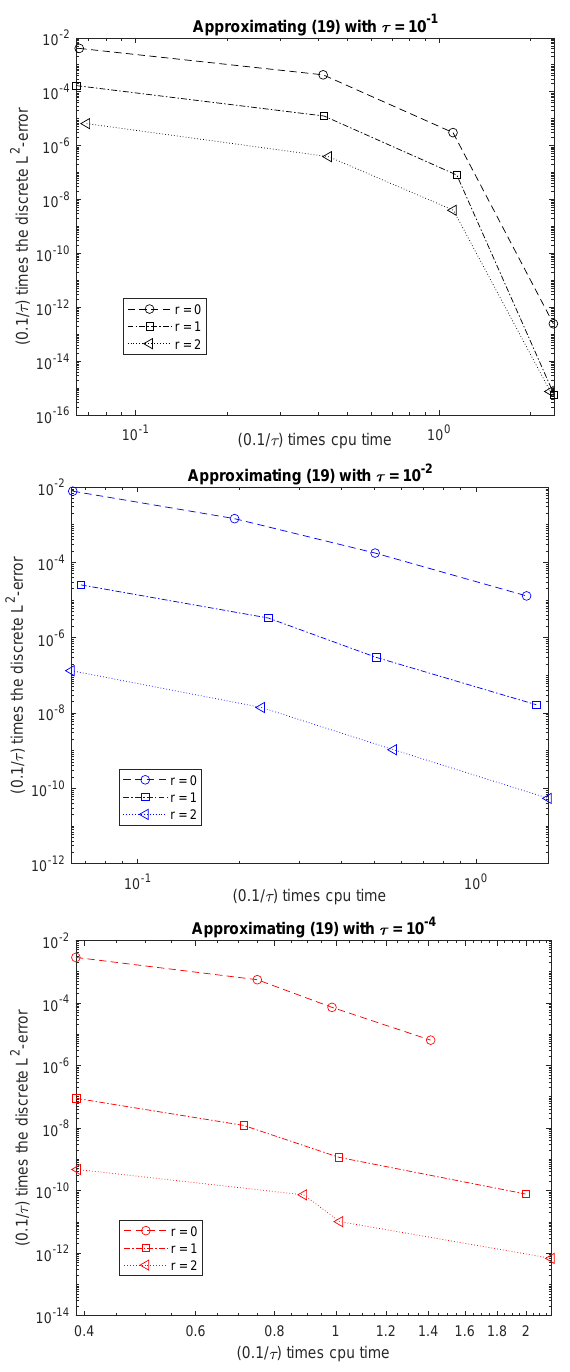
Figure 6. ( 0.1/ τ ) times the discrete L 2 -error against ( 0.1/ τ ) times CPU time when approximating (19) for the data in Section 2.1 for τ = 0.1 ( m = 300,600,900,1200), τ = 10 − 2 ( m = 100,200,300,400) and τ = 10 − 4 ( m = 10,20,30,40), r = 0,1,2 and fixed h = 10 − 3